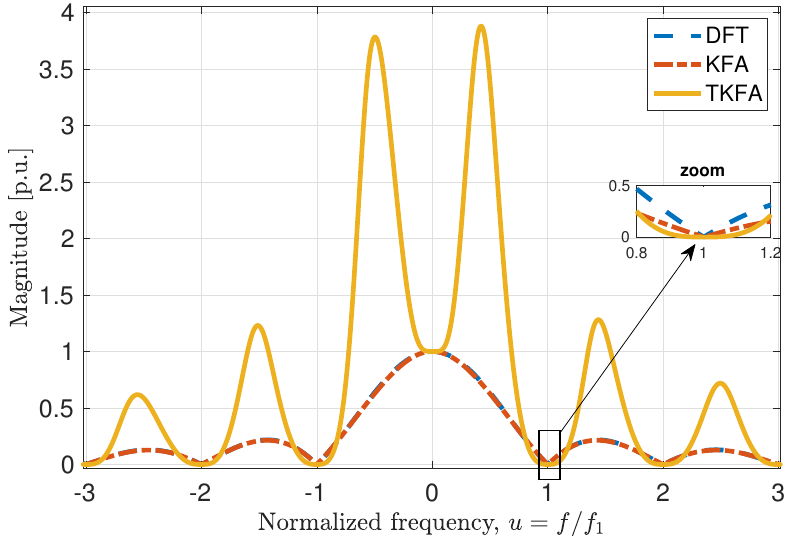
Figure 6. Magnitude response of DFT, KFA and TKFA algorithms with Q = 10 − 1 , P r = 10 10 and R =